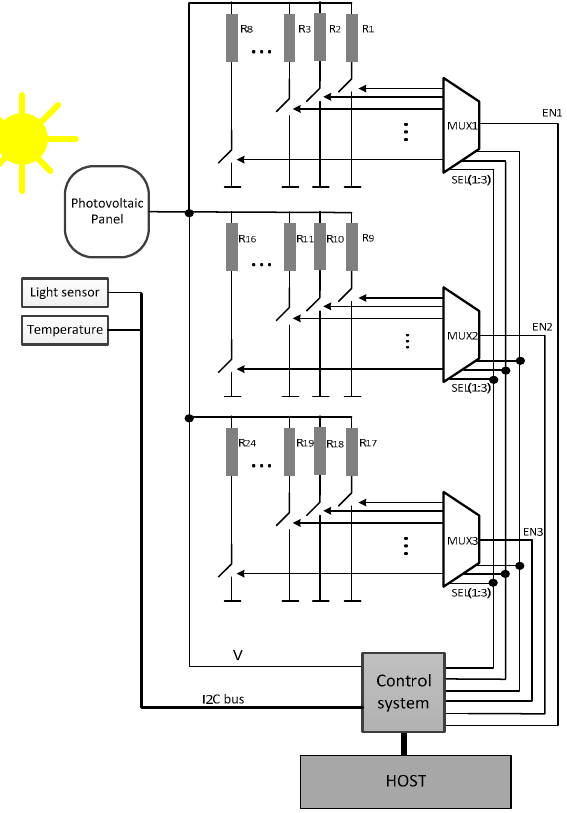
Figure 2. Proposed PV panel characterization system.